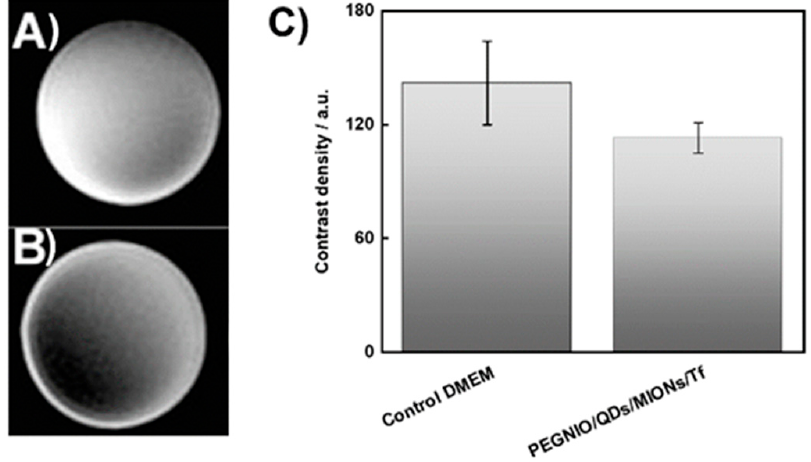
Figure 6. MRI of U87 cells after 2h incubation with control DMEM ( A ) and PEGNIO/QDs/MIONs/Tf ( B ). The histograms show the density of the MR images ( C ). Error bar means ± S.D. ( n = 4) with p < 0.05.